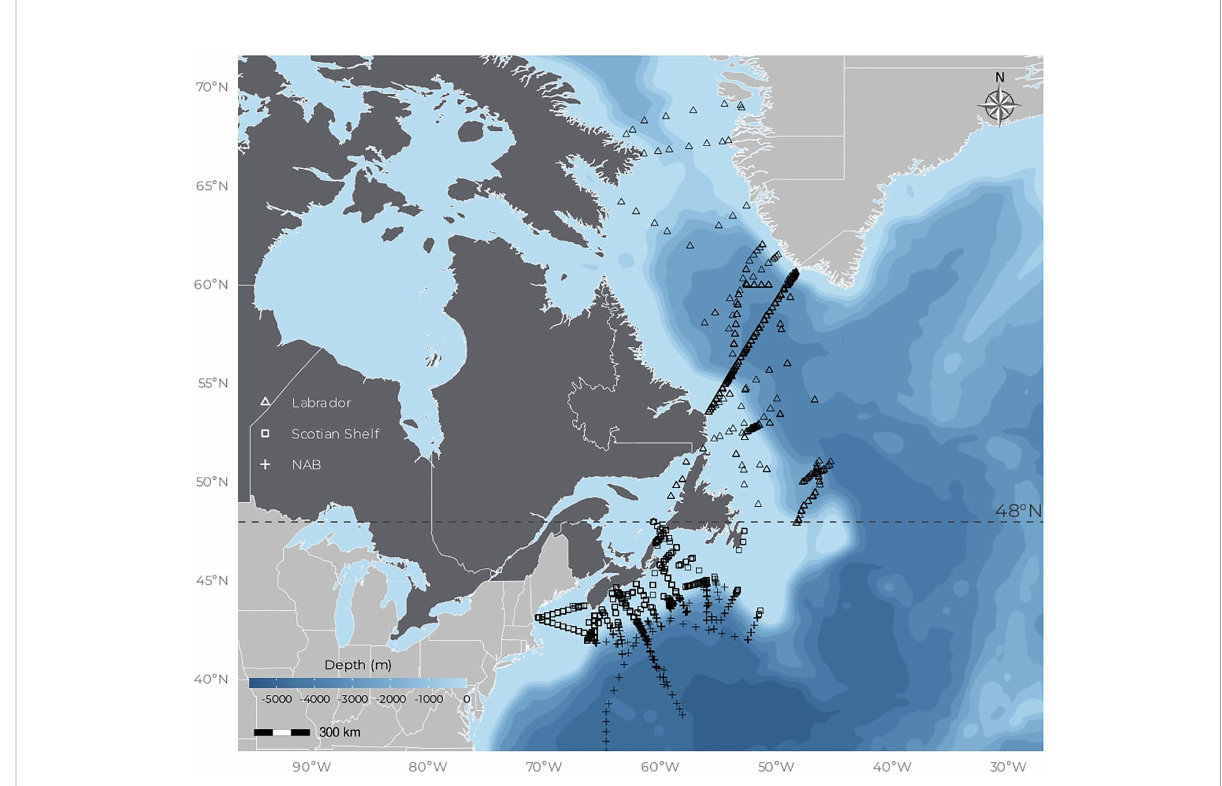
FIGURE 1 Location of samplings. The blue background indicates the bathymetry (see color bar in the bottom left panel). Dark gray corresponds to Canada and light gray corresponds to other countries (i.e., United States of America and